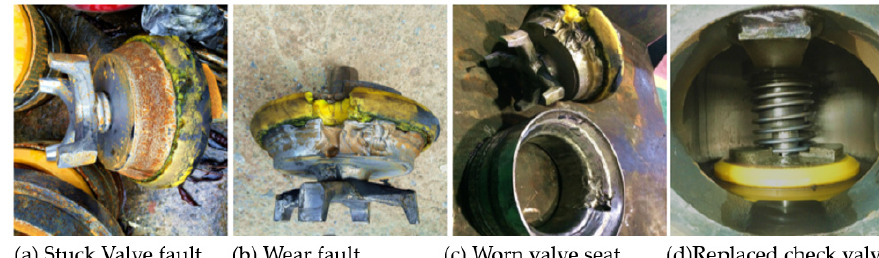
Figure 10. Fault check valve.